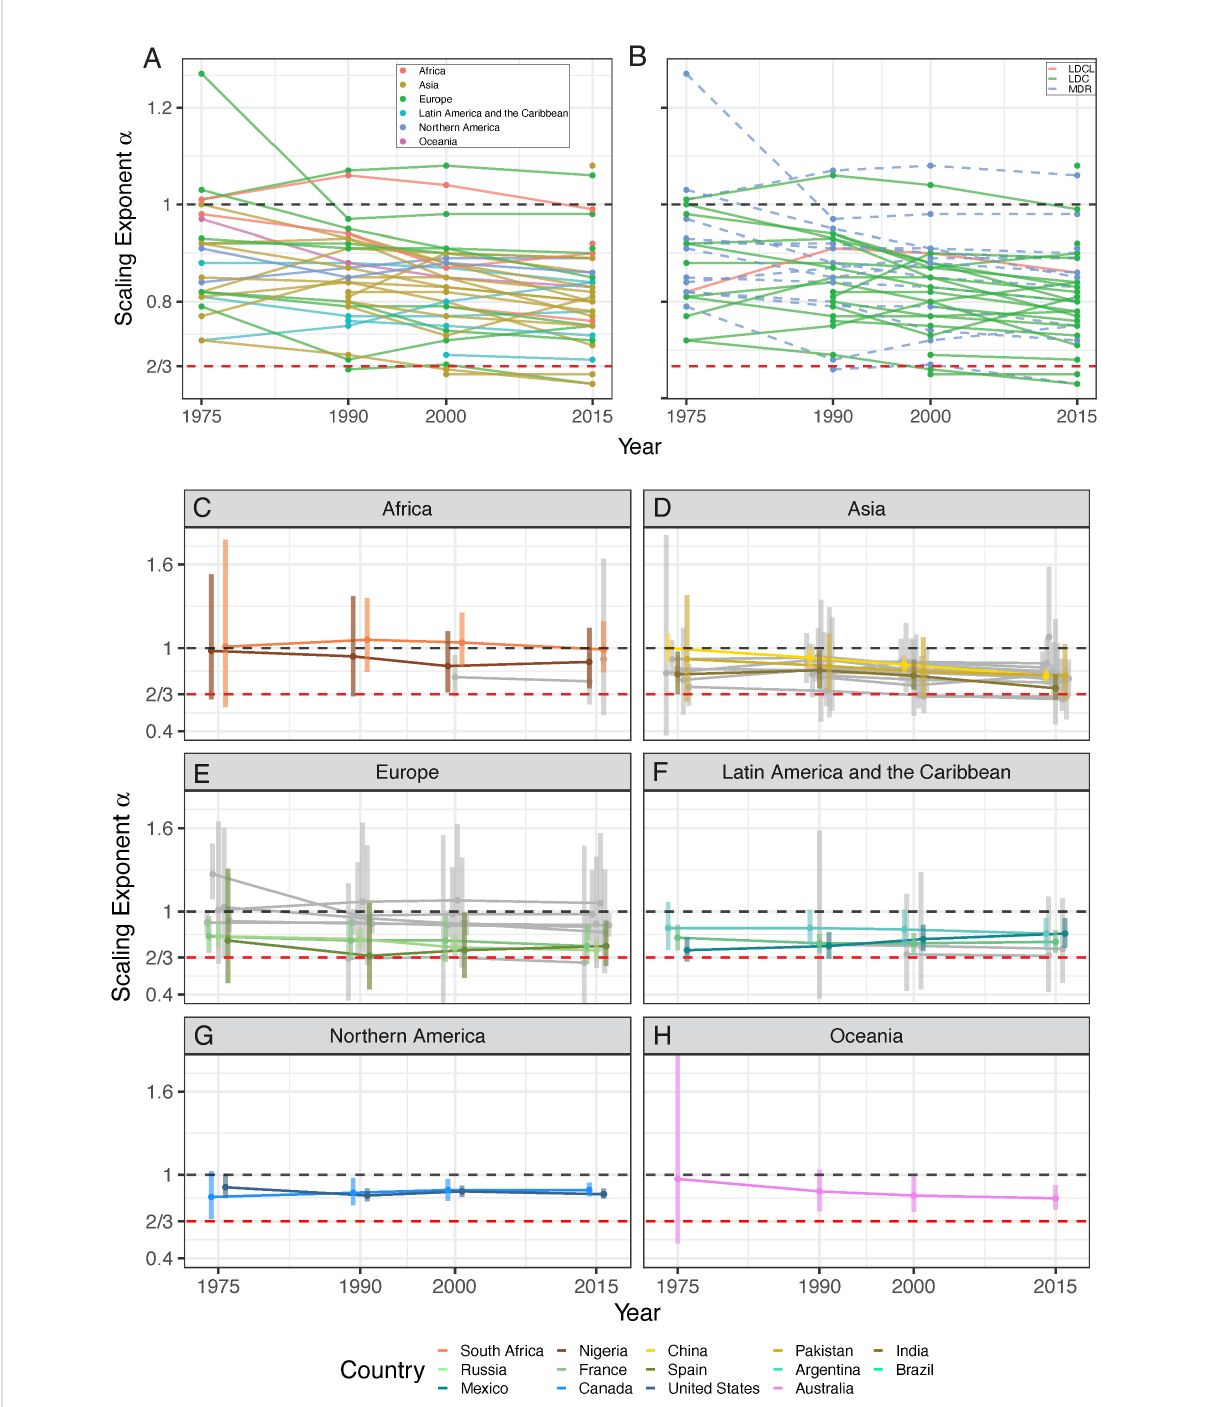
FIGURE 3 Scaling exponents over time by: (A) all regions, (B) 2015 economic development status, (C) Africa, (D) Asia, (E) Europe, (F) Latin America and the Caribbean, (G) Northern America, (H) Oceania. Note each line represents the exponent for a country over time and vertical lines 95% Con fi dence Intervals. Select countries listed in the legend are